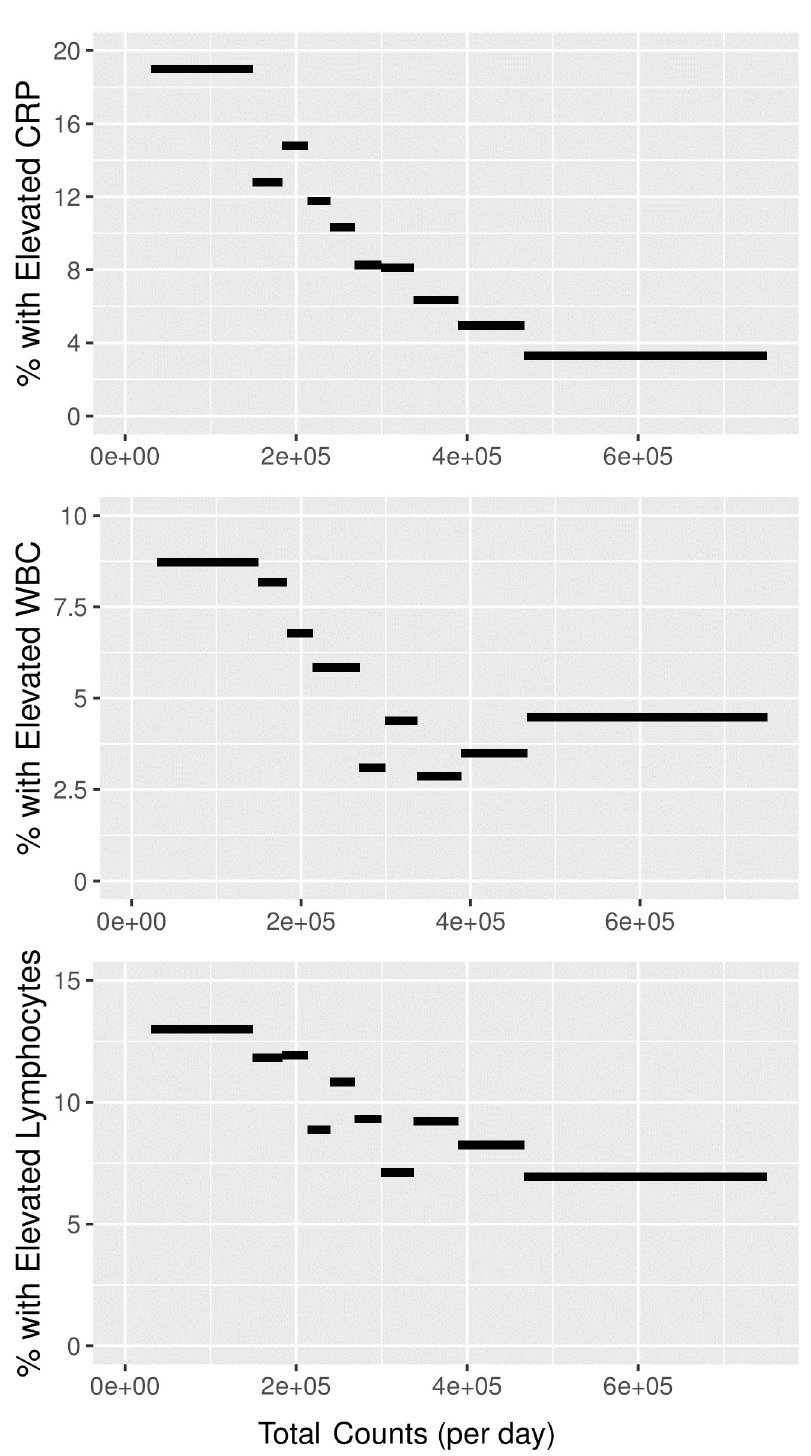
Fig 5. Higher physical activity corresponds to lower risk of elevated clinical serum levels. Greater daily physical activity measured using accelerometry (mean total counts per day) is associated with a lower prevalence of clinically elevated CRP, white blood cell count, and